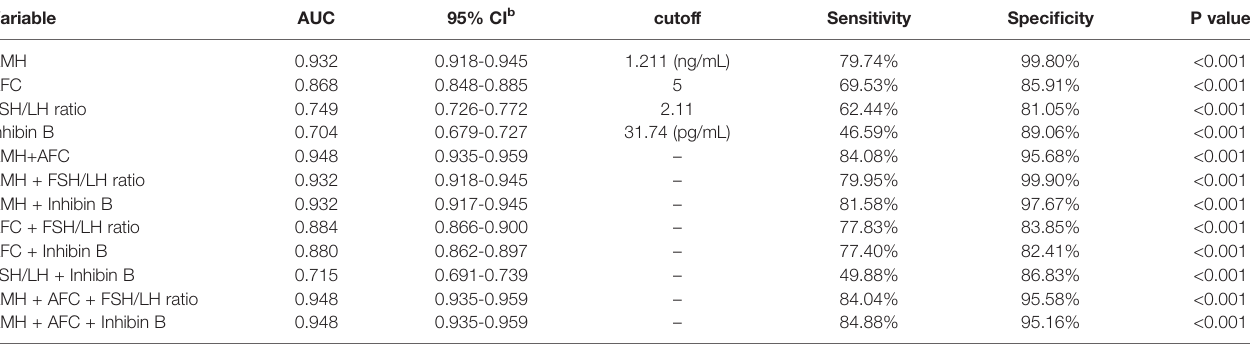
TABLE 2 | The ROC curve analysis for pre-POI prediction.